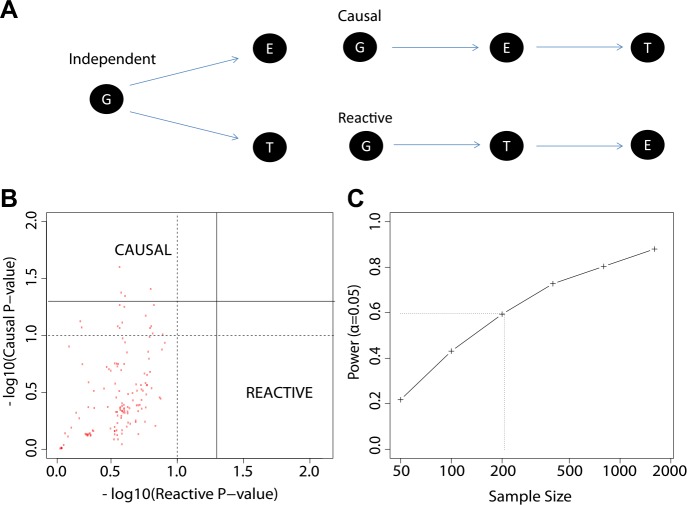
The study design permits causal and reactive model analyses.(A) Three models were evaluated, each showing a candidate hypothesis for the three-way association between genotype (G), expression (E) and trait (T). In the independent model, expression and trait each associate with genotype but are not themselves directly related. In the causal model, expression mediates the association between genotype and trait. In the reactive model, genotype and expression relate through the trait, so that gene expression changes are a downstream response to the trait. (B) p-values for independent-versus-reactive and independent-versus-causal hypothesis tests. Each point shows the result for one SNP-transcript pair. Points to the right of the solid vertical line are significant (p<0.05) for the reactive hypothesis and points above the solid horizontal line are significant for the causal hypothesis. The dashed line shows a p=0.1 threshold. (C) Power for rejection of the independent hypothesis. Non-independent data were simulated with effect sizes and variances similar to those in the enrichment set (the set of SNP-transcript pairs that were found to be significant in our study). The curve shows the proportion of cases in which the simulated data rejected the independent (null) hypothesis. The dotted line indicates the combined sample size in our study.